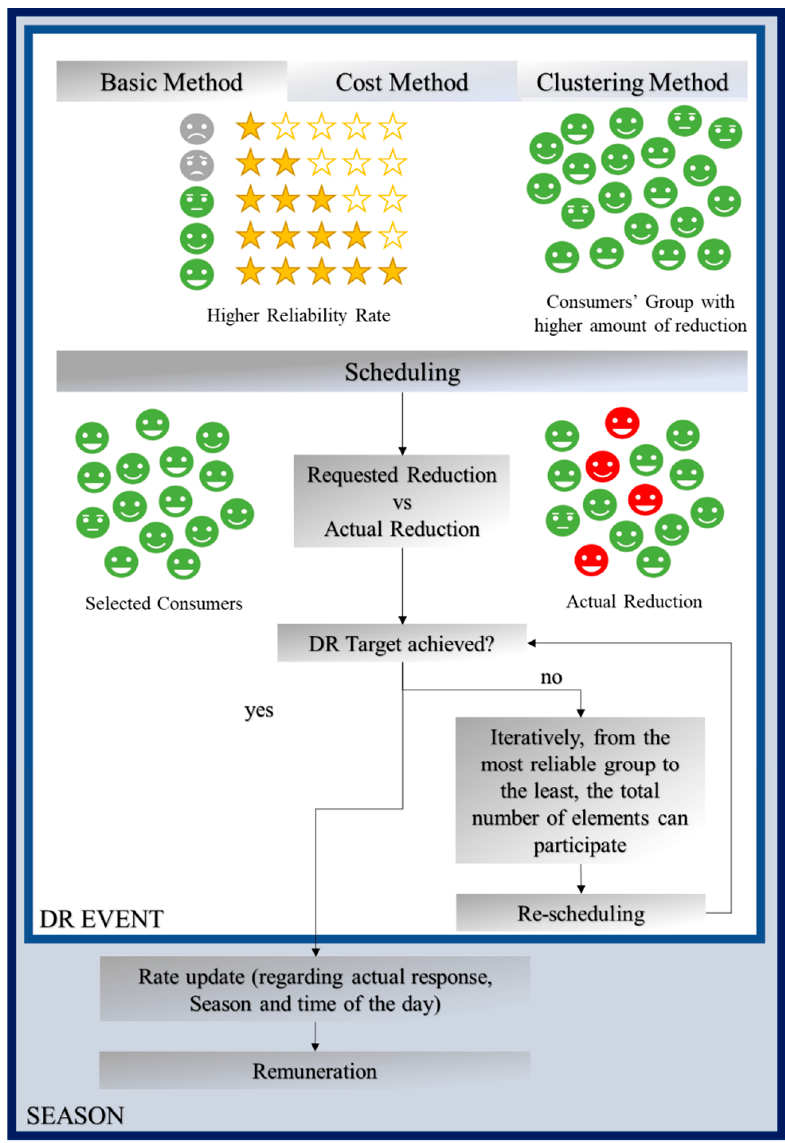
Figure 2. Proposed methodology.